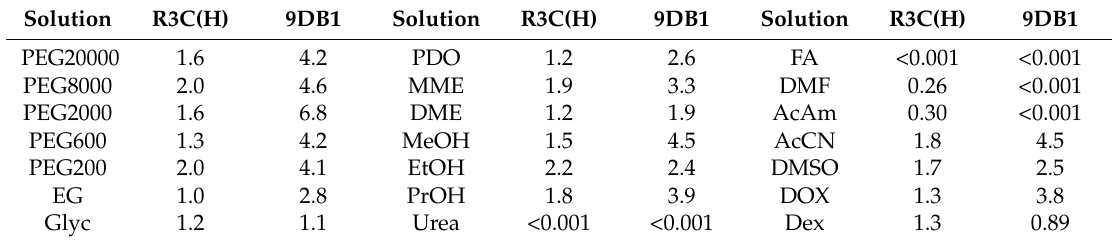
Table 3. Fold increase in the rates of the R3C(H) -catalyzed and 9DB1 -catalyzed single-turnover reactions in mixed solutions in the presence of 10 mM MgCl 2 over the rates in the absence of organic